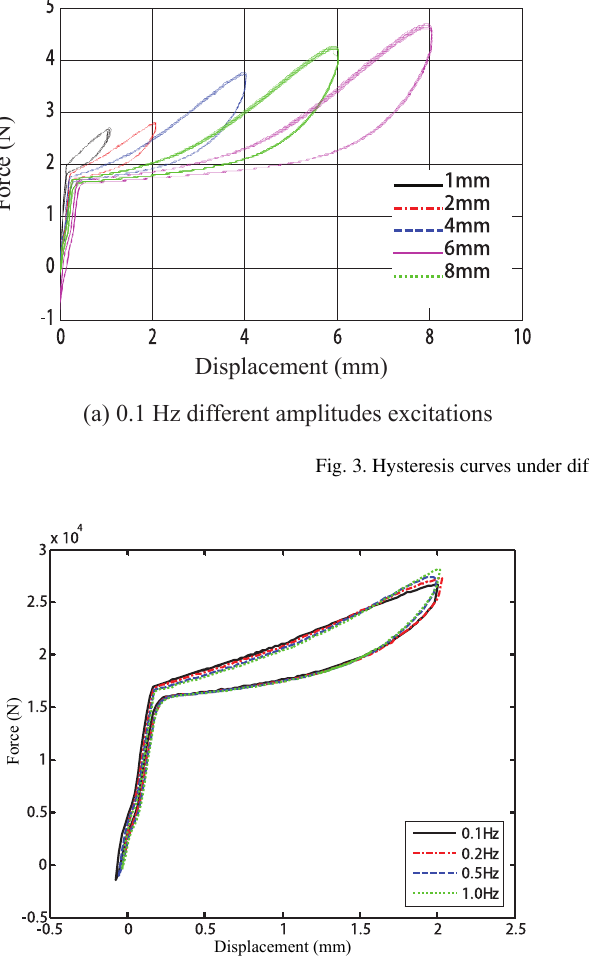
Fig. 5. Hysteresis curves under 4 mm amplitude with various fre- quency